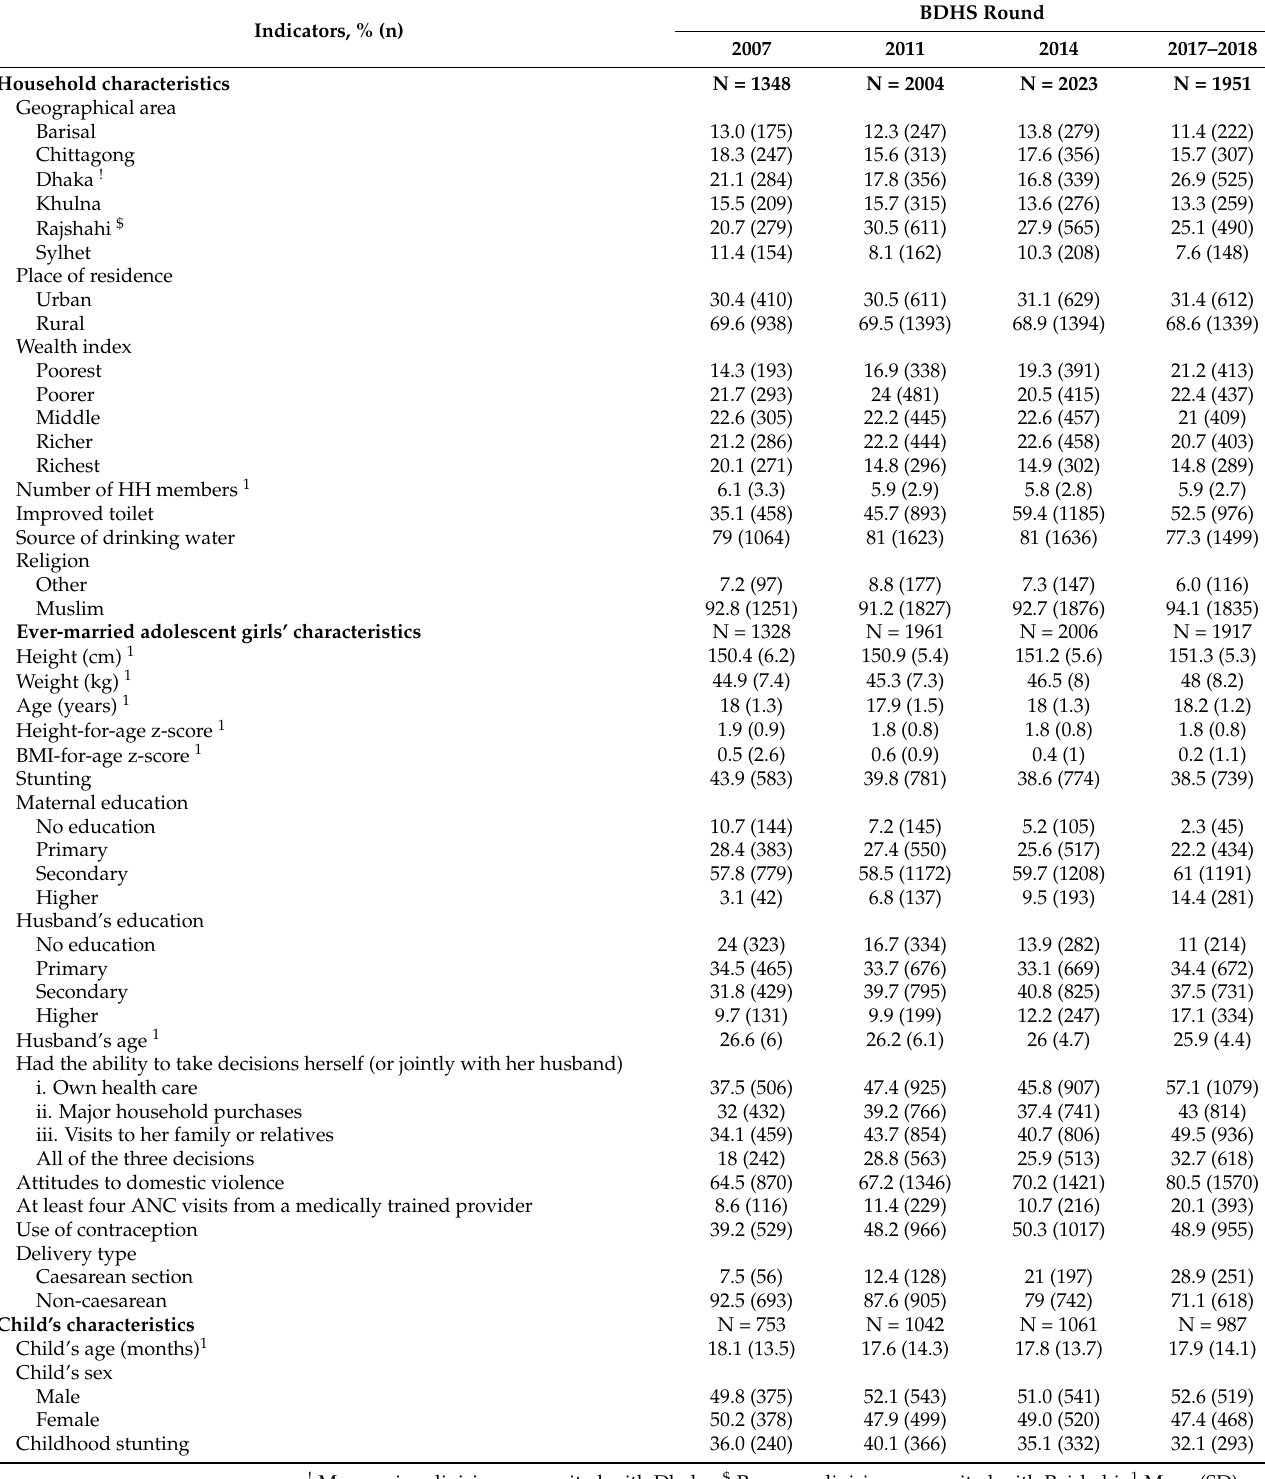
Table 1. General characteristics of the participants stratified by round of the BDHS